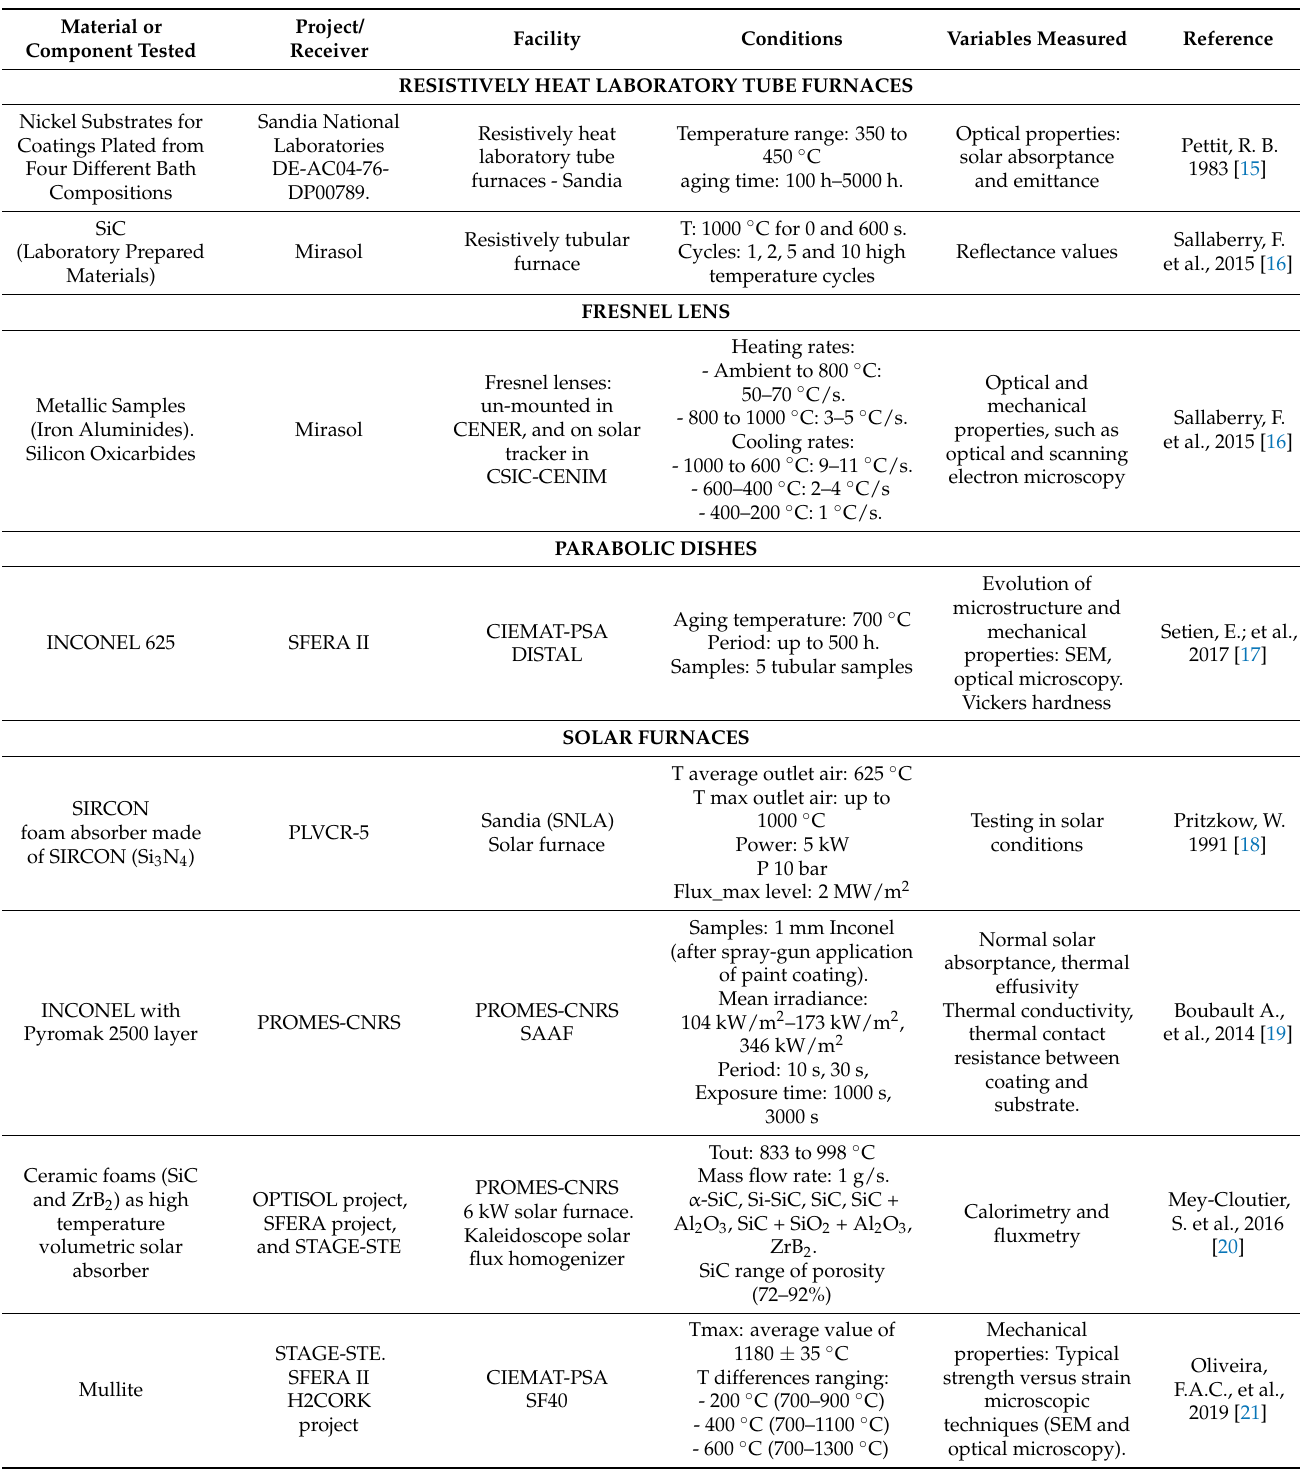
Table 1. Selected test methods for materials or components tested in point focus facilities and resistively heat laboratory tube